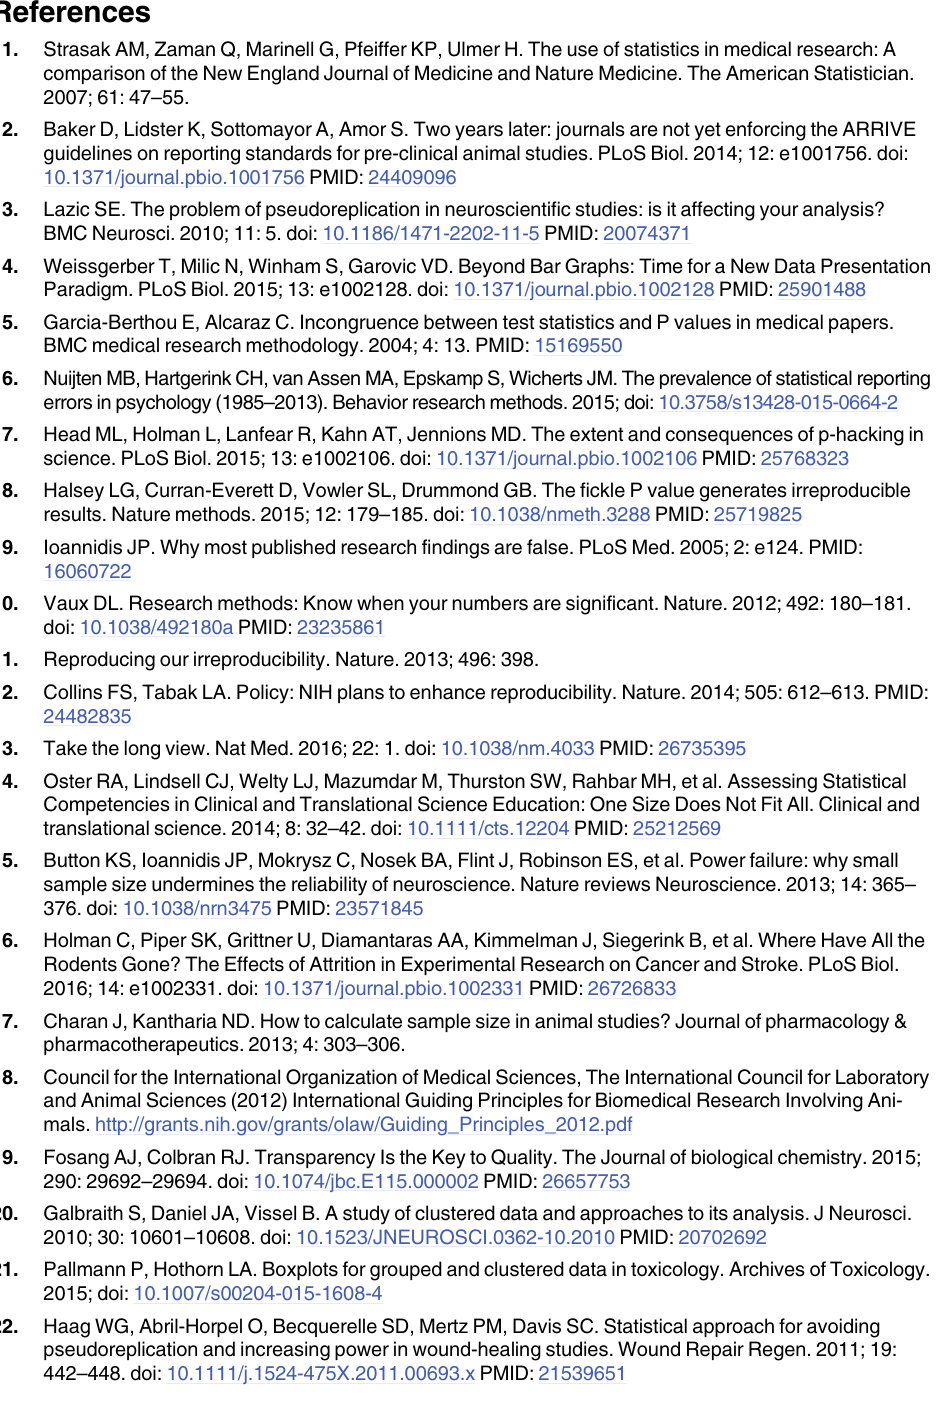
S2 Fig. Flow chart for study of statistical education practices in PhD